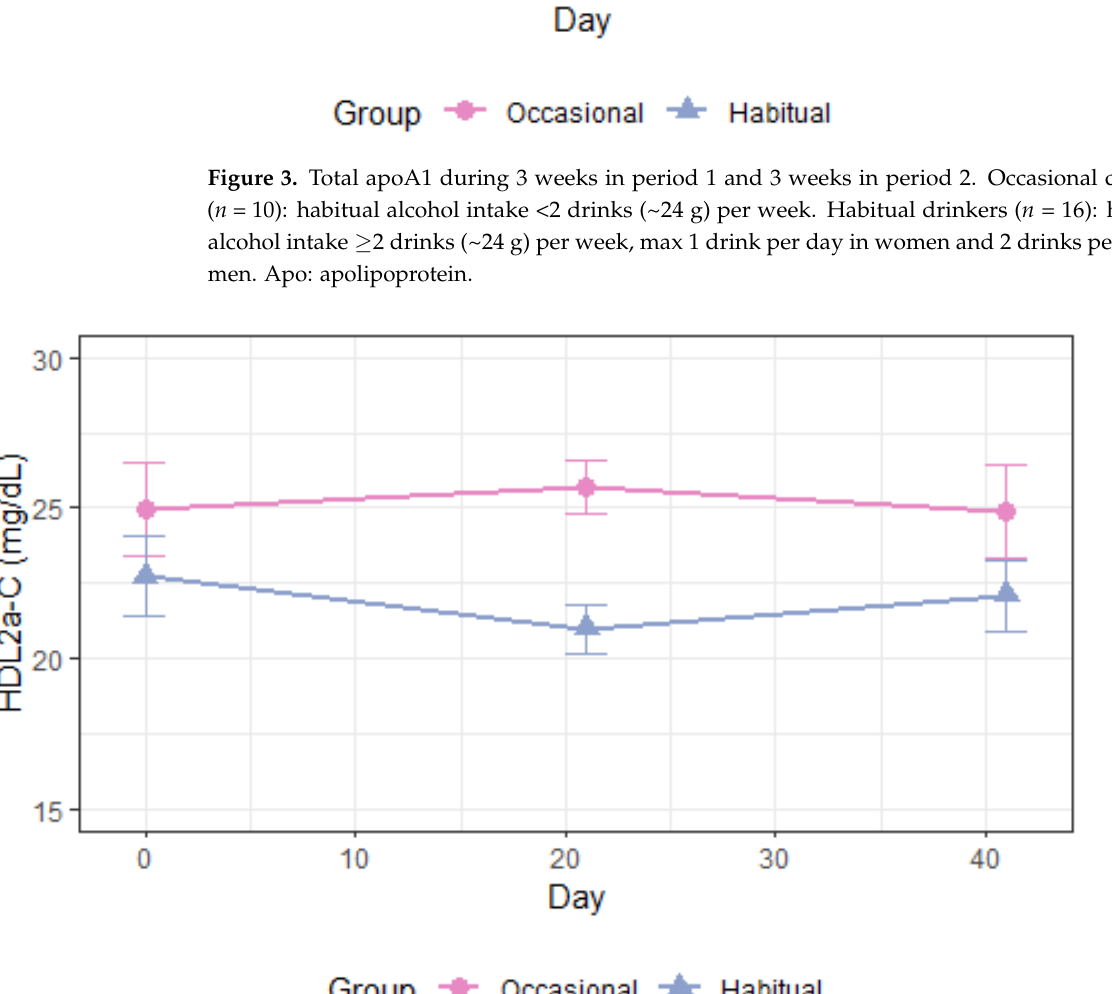
Figure 5. Circulating HDL 3 -C during 3 weeks in period 1 and 3 weeks in period 2. Occasional drink- ers ( n = 10): habitual alcohol intake <2 drinks (~24 g) per week. Habitual drinkers ( n = 16): habitual alcohol intake ≥ 2 drinks (~24 g) per week, max 1 drink per day in women and 2 drinks per day in men. -C: cholesterol concentration, HDL: high-density lipoprotein.